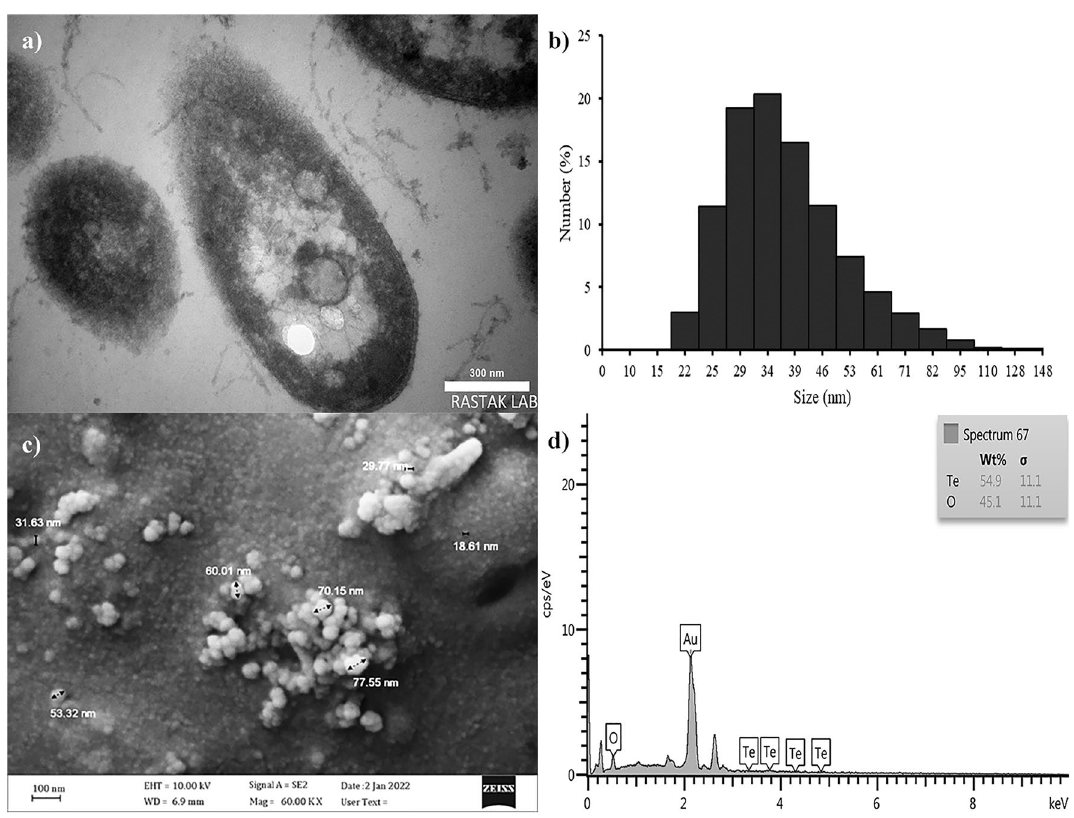
Figure 4. TEM micrograph ( a ), DLS analysis ( b ), FE-SEM image ( c ), and EDX spectrum ( d ) of the extracted TeNPs synthesized by Lysinibacillus sp.